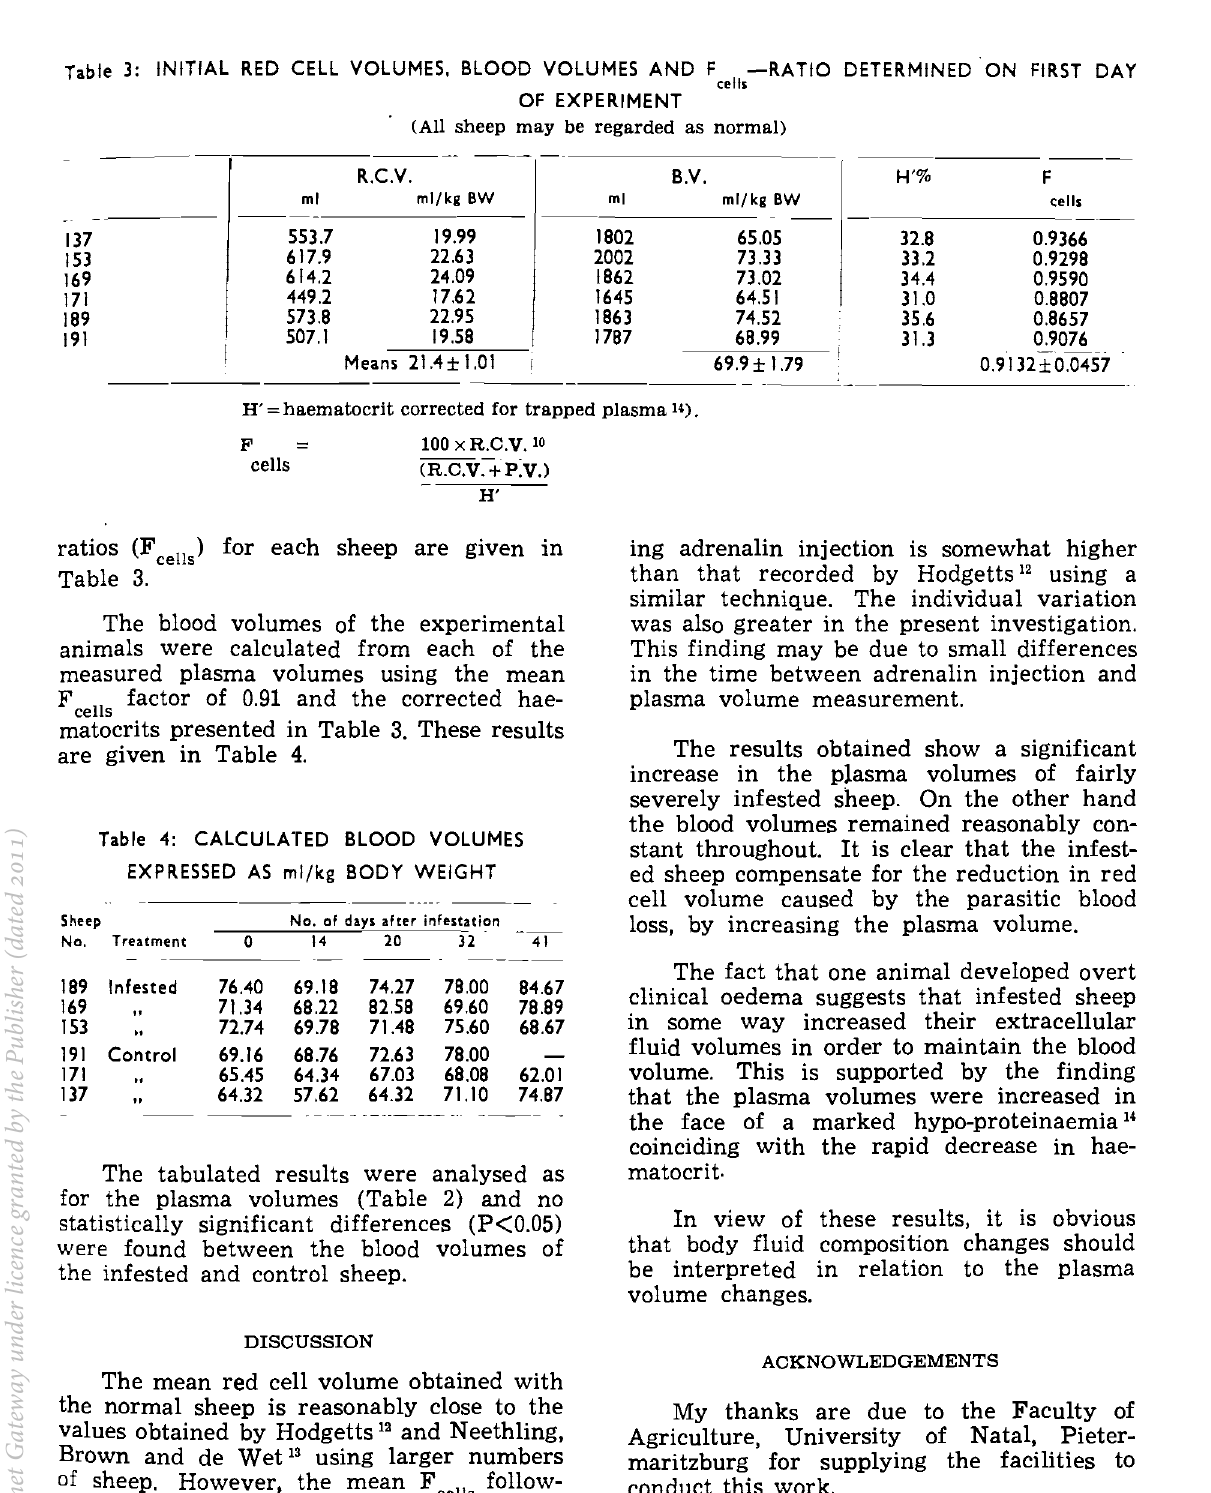
Table 3: INITIAL RED CELL VOLUMES, BLOOD VOLUMES AND F -RATIO DETERMINED ON FIRST DAY